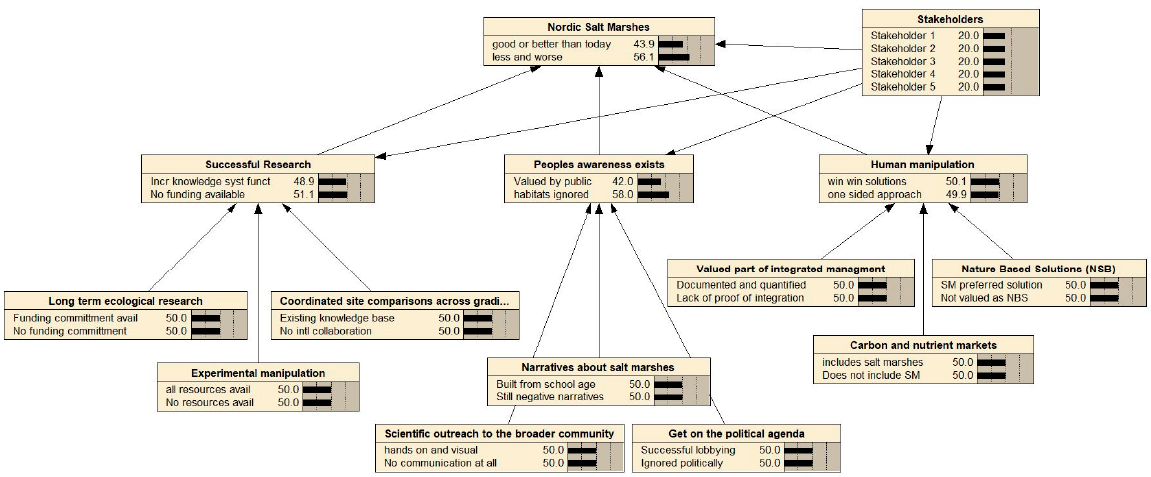
Figure 4. Modelled probability outputs of BBN in the state of ‘business as usual’.